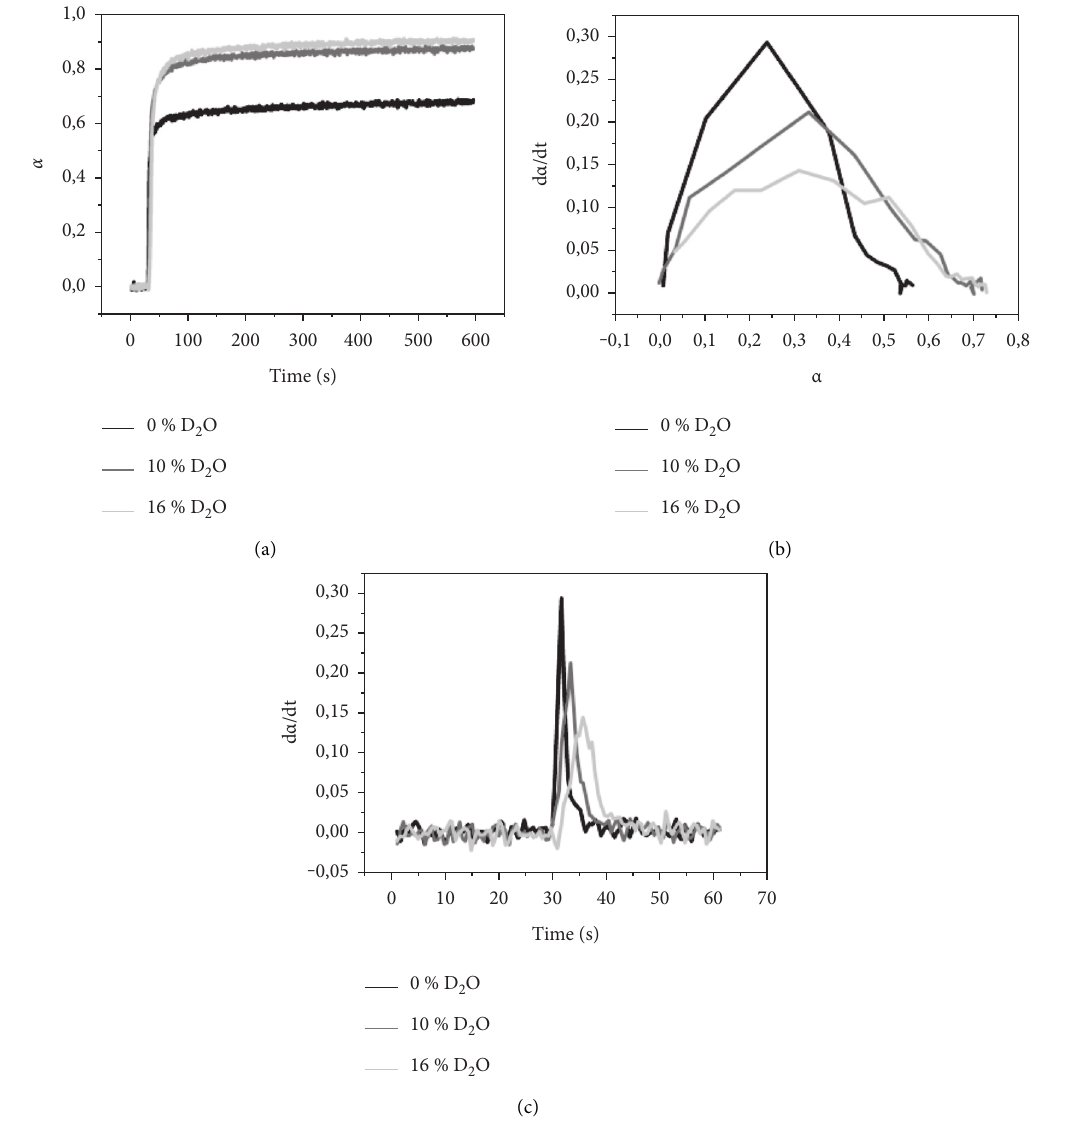
Figure 1: Polymerization kinetics of adhesives with different amounts of deuterium in their formulation: (a) DC over time; (b) poly- merization rate by time; (c) polymerization rate by DC. α is the fraction of reacted